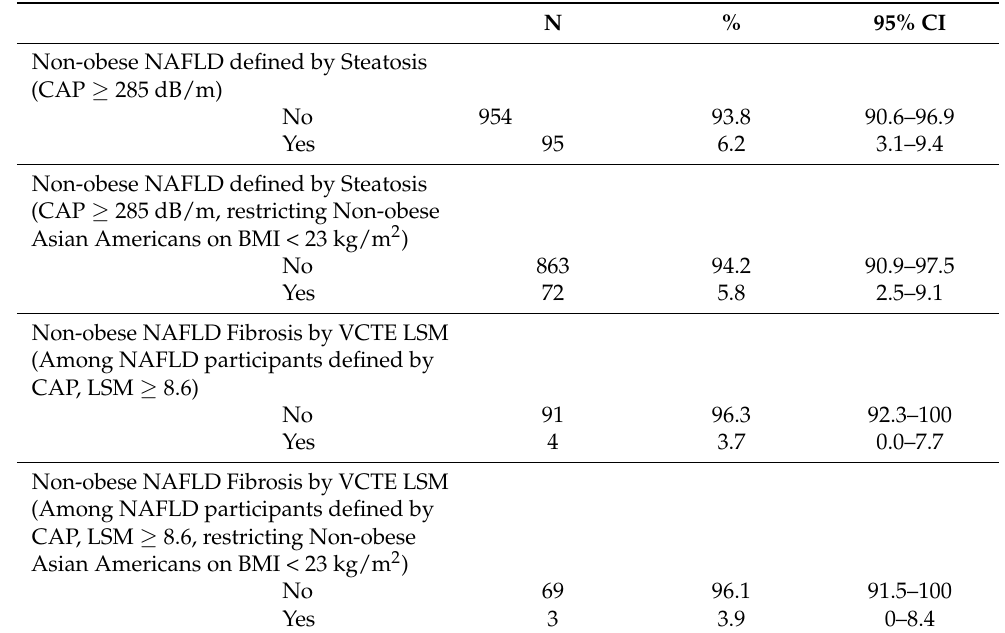
Table 2. Prevalence of non-obese NAFLD and non-obese NAFLD fibrosis.